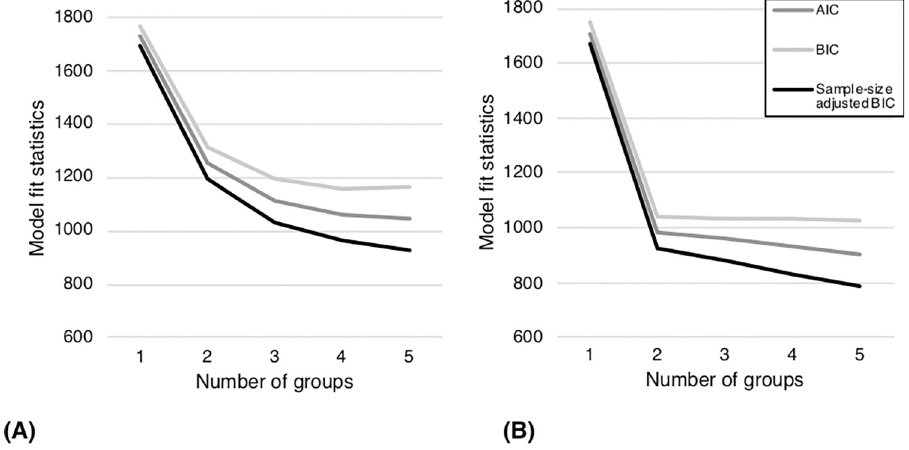
Fig 4. Model fit statistics for 1–5 group solutions for AP-S showing (a) AP-S chroma accuracy and (b) AP-S chroma accuracy ST.